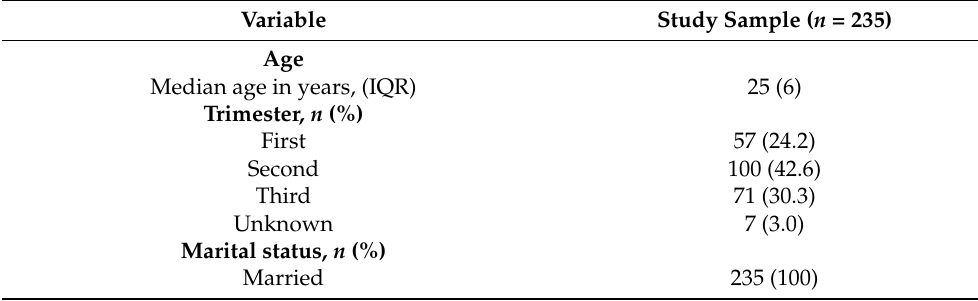
Table 1. Summary of respondent (pregnant women)